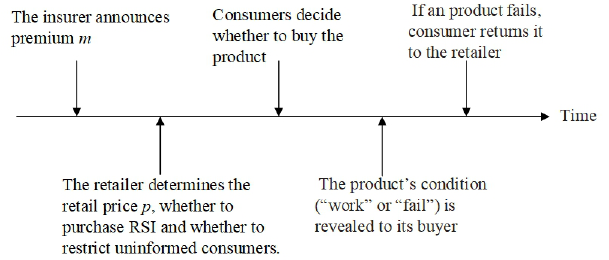
Figure 1. Sequence of